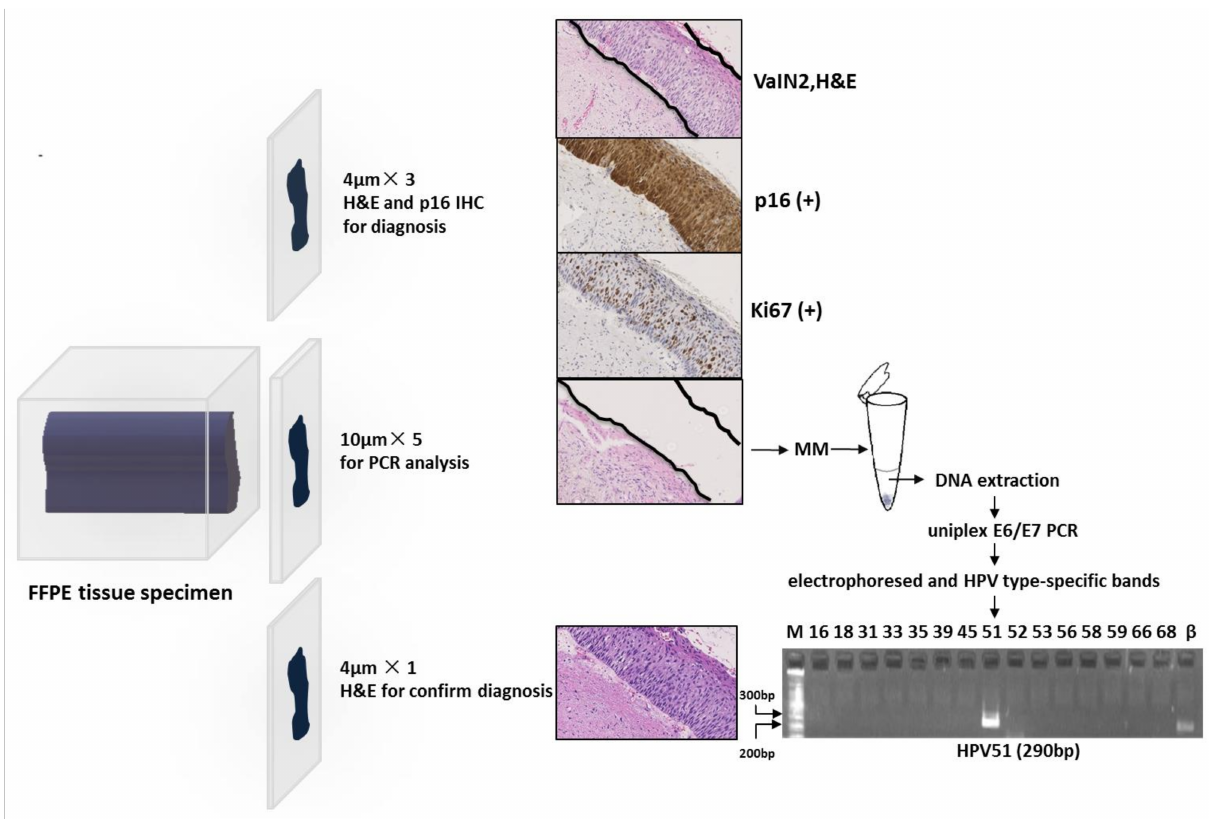
Figure 2. Stratification of patients investigated for vaginal squamous intraepithelial tissue lesions Bp: base pair; FFPE: formalin fixed, paraffin embedded; H&E: haematoxylin and eosin; IHC: immunohistochemistry; M: marker; MM: manual microdissection; PCR: polymerase chain reaction; β : β